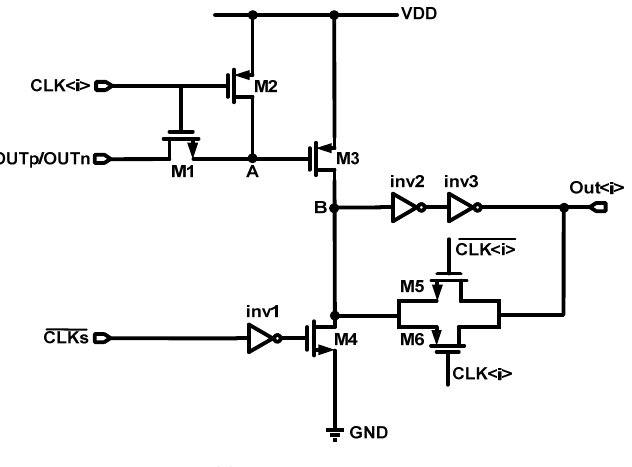
Figure 16. DAC control logic.